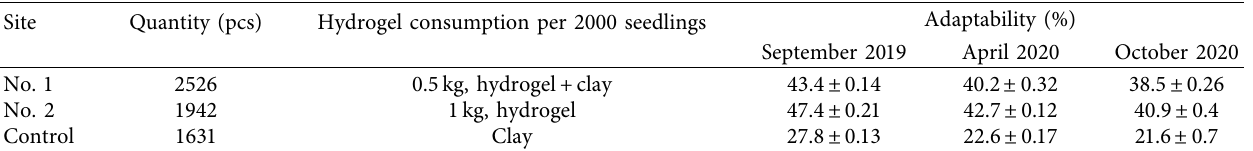
Table 1: Inventory of pine